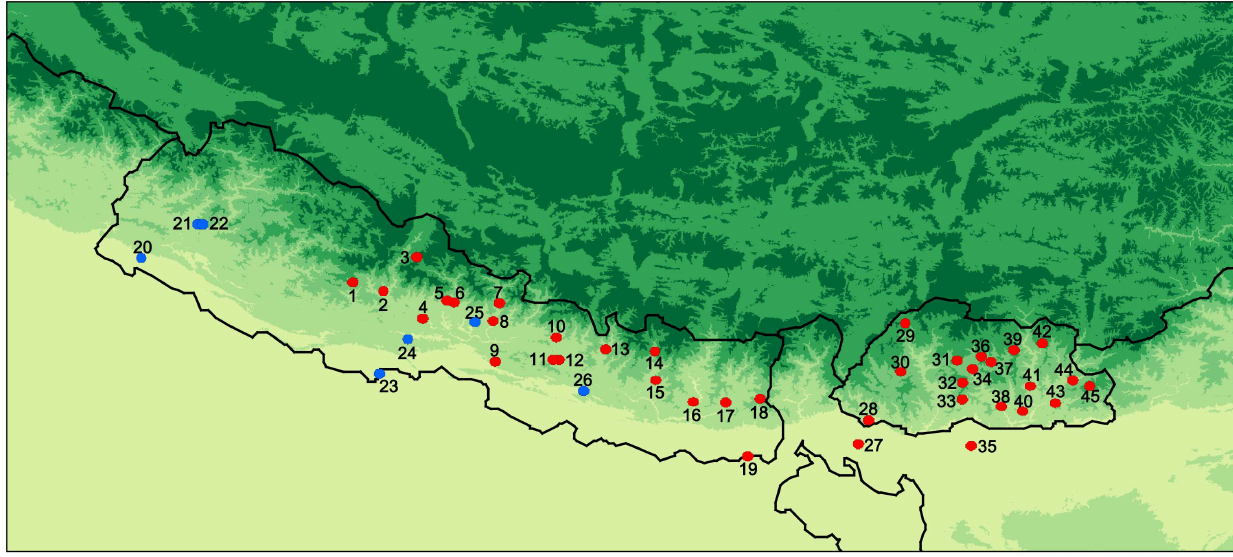
Figure 1. Distribution of ethnolinguistic groups/pools sampled in Nepal and Bhutan. Blue dots indicate the approximate geographical centres of the Indo-European groups/pools and red dots indicate the approximate geographical centres of the Tibeto-Burman groups/pools. Populations from Nepal: 1=Kham, 2=Chantyal, 3=Thakali, 4=Magar, 5=Dura, 6=Gurung, 7=Ghale, 8=Bara¯m, 9=Chepang, 10=Tamang, 11=Newar, 12=High caste Newar, 13=Thangmi, 14=Sherpa, 15=Western Kiranti (pool), 16=Central Kiranti (pool), 17=Eastern Kiranti (pool), 18=Limbu (pool), 19=Dhimal, 20=Artisanal caste Indo-Aryan (pool), 21=Bahun, 22=Chetri, 23=Tharu, 24=Majhi, 25=Kumal, 26=Danuwar & Kachadiya Danuwar (pool). Populations from Bhutan and India: 27=Toto (India), 28=Lhokpu, 29=Layap, 30=’Ngalop, 31=Lakha, 32=Mangde, 33=Black Mountain Mo¨npa, 34=Nup, 35=Bodo (India), 36=Brokkat, 37=Bumthang, 38=Khengpa, 39=Kurto¨p, 40=Gongduk, 41=Chali, 42=Dzala, 43=Tshangla, 44=Dakpa, 45=Brokpa. (cid:2) John Benjamins Publishing Company, Amsterdam/Philadelphia.